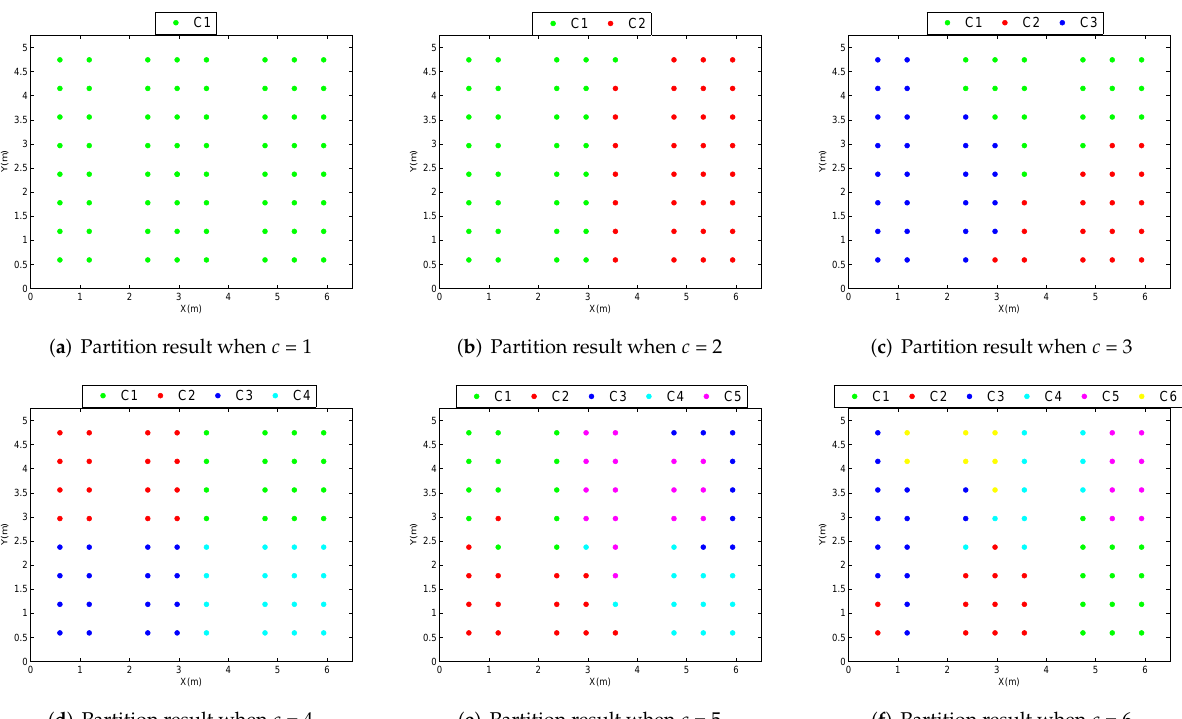
Figure 8. The RP partition results of the Fuzzy c-means clustering method in a complex